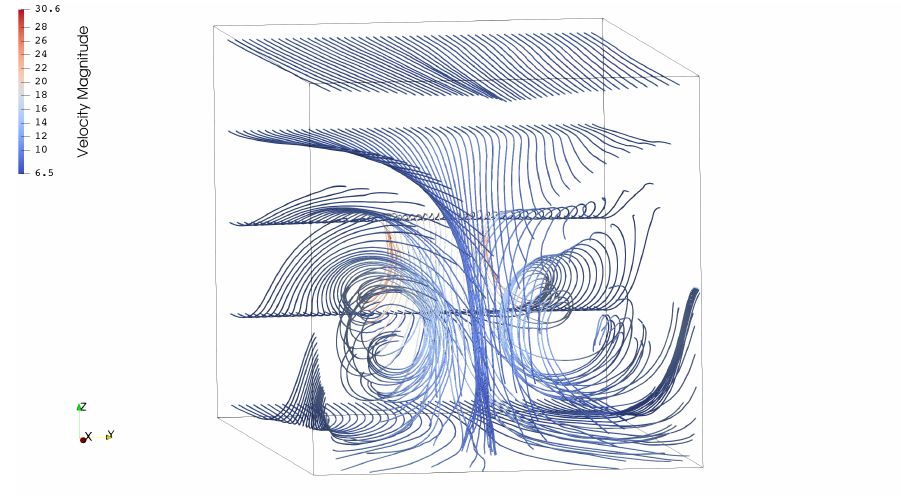
Figure 36. Streamlines of the solution in Figure